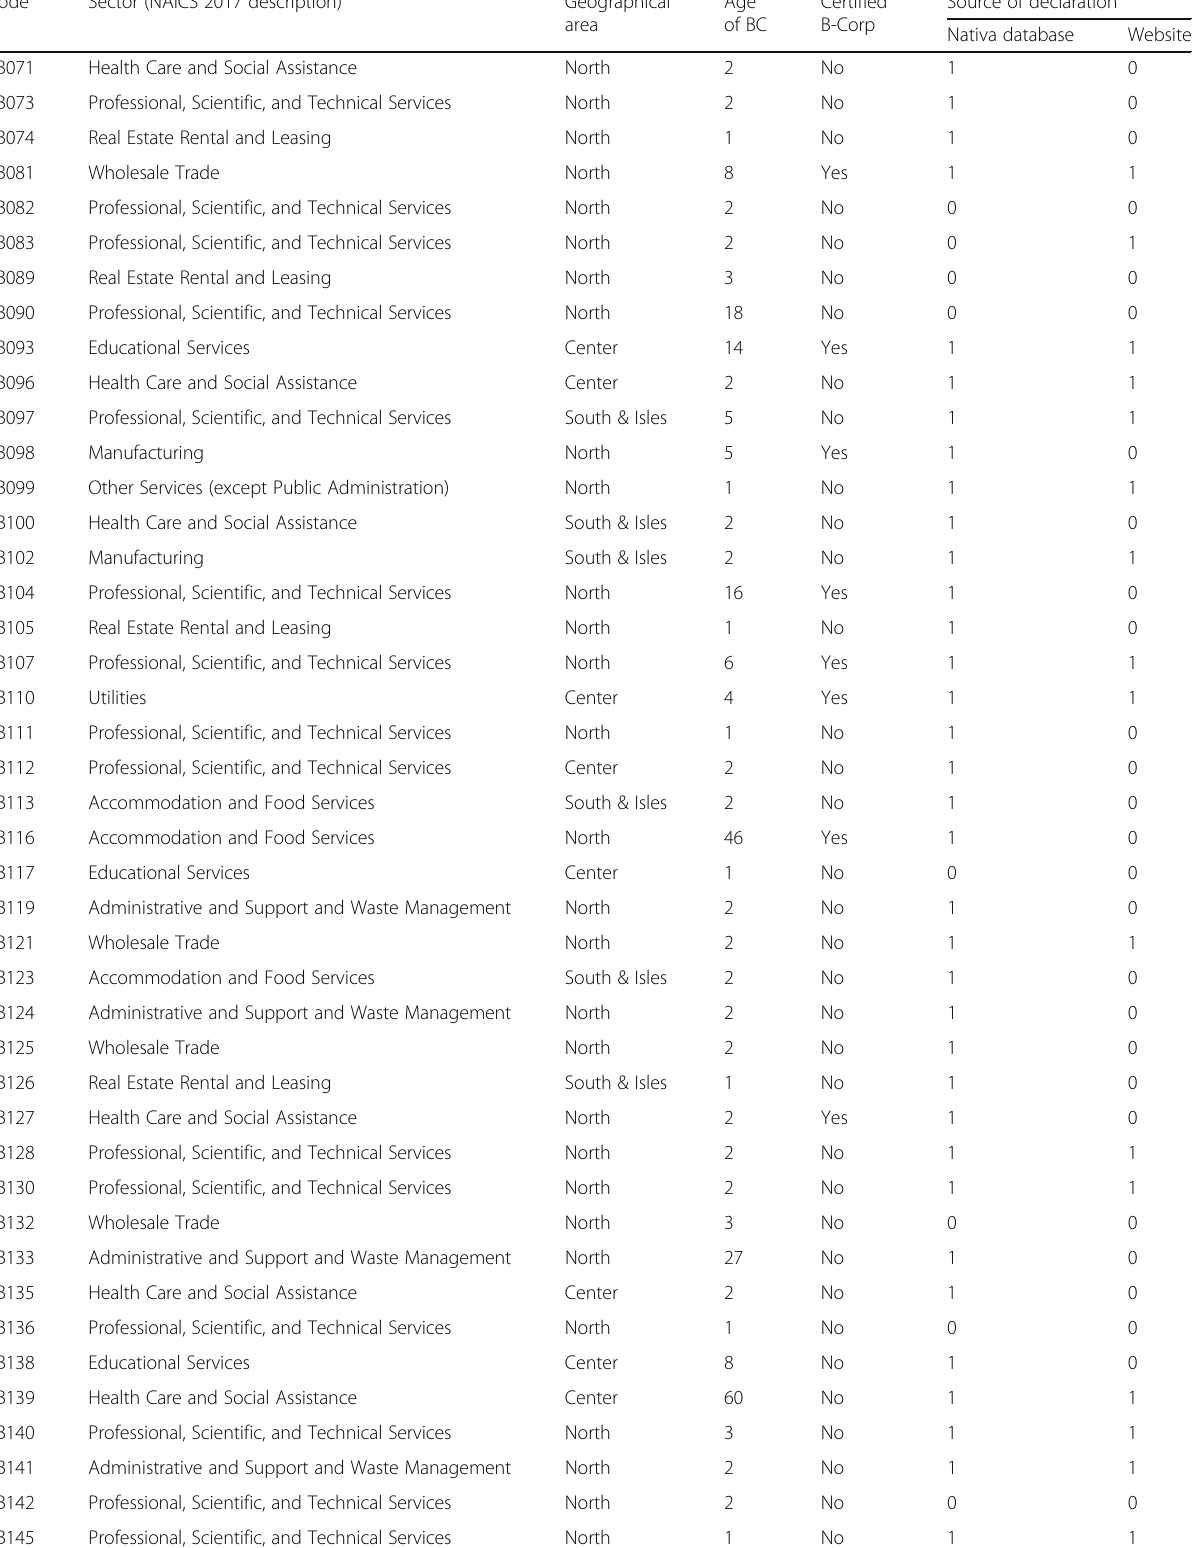
Table 1 Sample of analysis and main characteristics of BCs